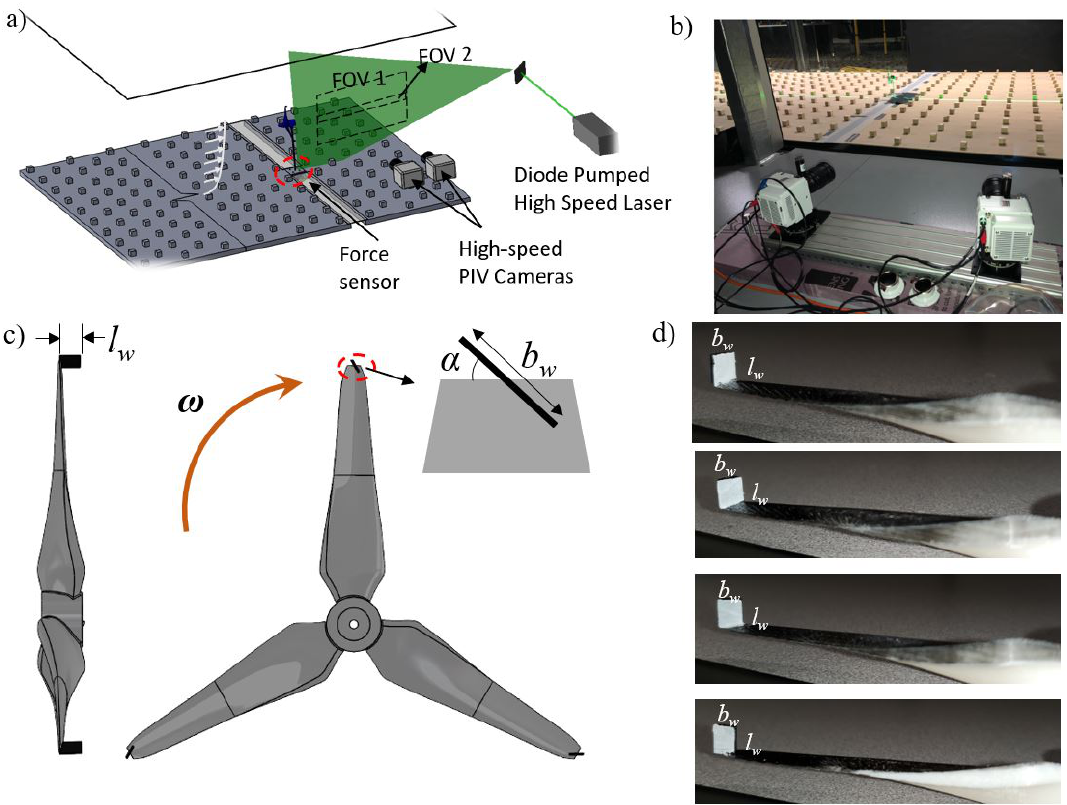
Figure 1. ( a ) schematic of the experimental setup illustrating the PIV system, force sensor, and bottom wall roughness; ( b ) photograph of the experimental setup in BLAST; ( c ) details of the turbine rotors highlighting the definition of winglet pitching angle from lateral (left) and leeward (right) side views. The orange arrow indicates the clockwise direction of turbine rotation from the leeward sight; ( d ) photographs of blade tips with winglet with pitching angles at α = 0 ○ ,30 ○ ,60 ○ and 90 ○ (from top to bottom). The leeward surface of the turbine was painted black and the winglet was paint